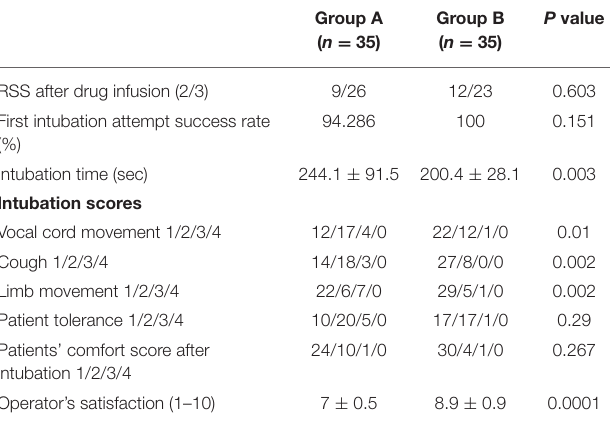
TABLE 2 | Airway management characteristics.